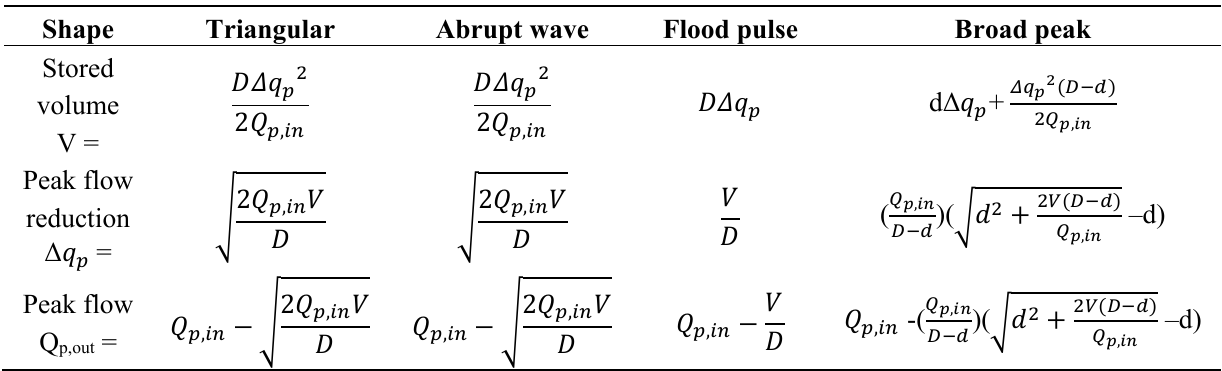
Table 1. Maximum peak reduction and ideal peak outflow for simple hydrographs given peak inflow (Q p,in ), flood duration (D), maximum inflow duration (d) and flood storage volume V Δ q p = Q p,in − Q p,out.